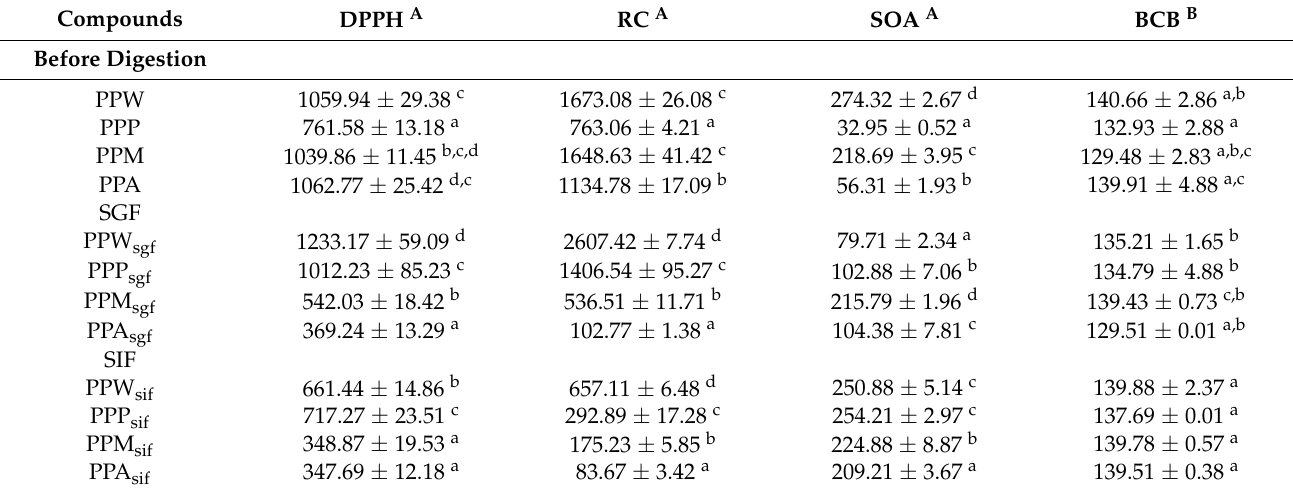
Table 3. Antioxidant activity of encapsulates before and after in vitro gastrointestinal digestion.